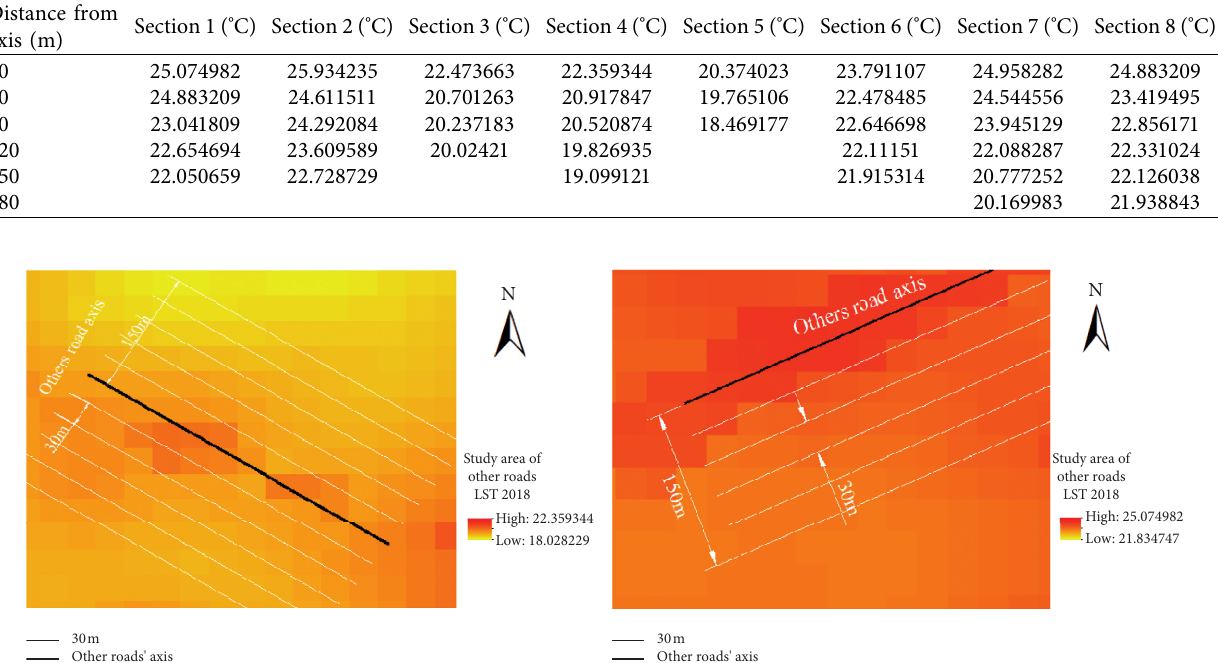
Figure 9: LST radiation conditions in typical areas of other grades of